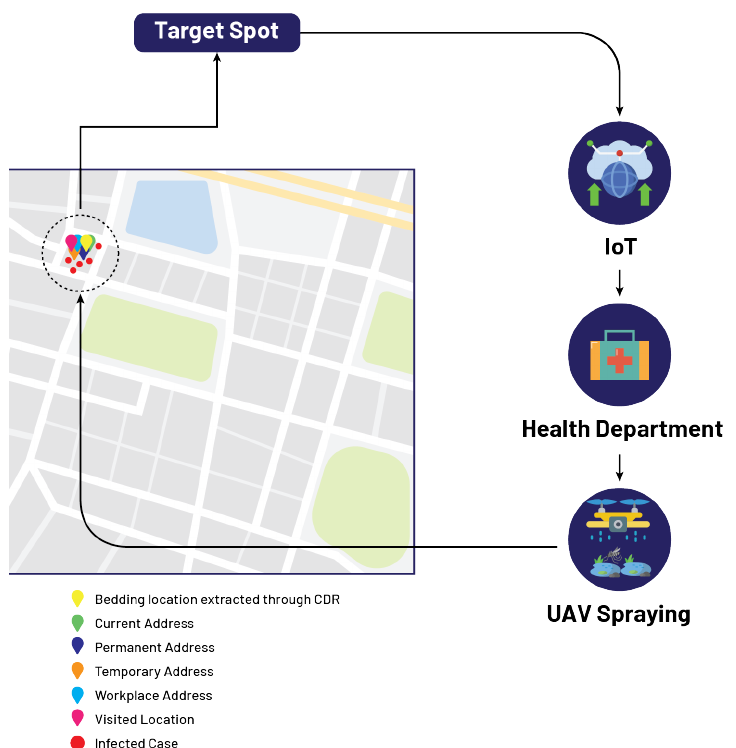
Figure 4. Localization of target spot based on proposed model.